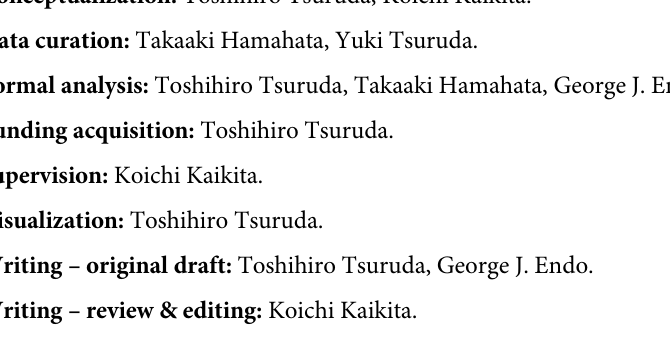
S1 Table. Bystander CPR in patients with OHCA of cardiac cause, and bystander AED in all EMS- transported patients with OHCA in Miyazaki city district, and Kyushu-Okinawa regionbetween 2015 and 2019. S2 Table. One-month survival rate in OHCA patients of cardiac cause in Miyazaki city dis- trict and Kyushu-Okinawa region between 2015 and 2019. S3 Table. EMS transport time in Miyazaki city district (S3-1) and all over Japan (S3-2).